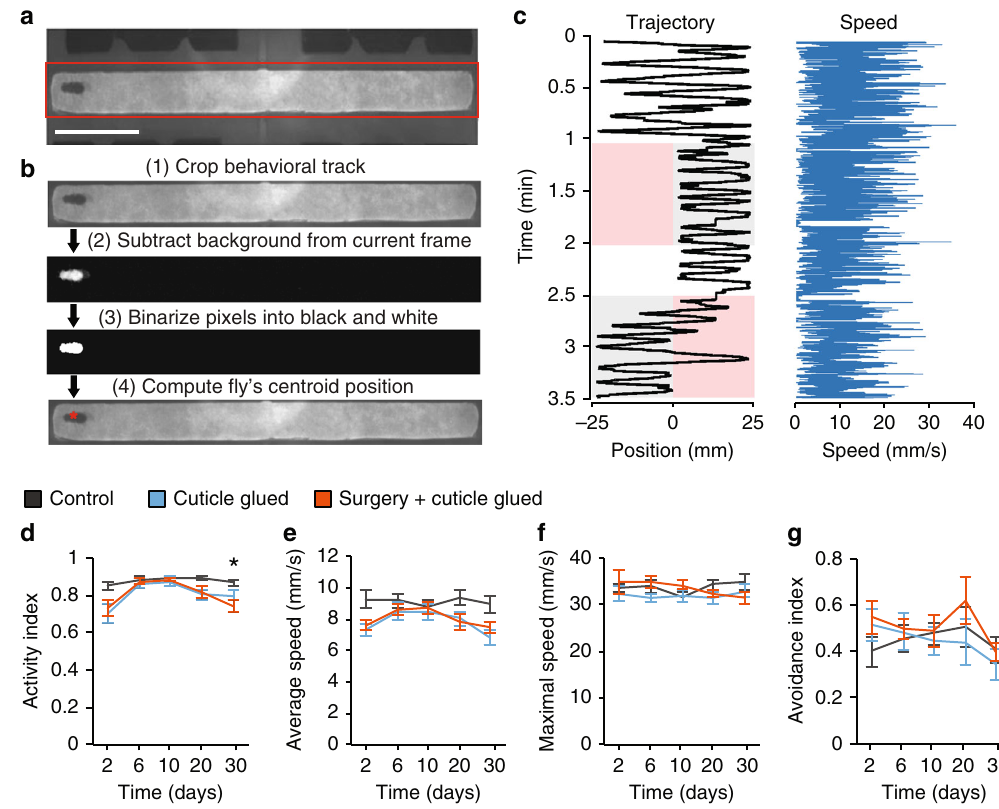
Fig. 3 Virtually normal locomotor and odor avoidance behaviors for 30 days after surgery. a Behavioral chamber for locomotor and odor avoidance assays, with odor delivery inlets at both sides. Red box: image region-of-interest analyzed to track fl y movements. Scale bar: 10 mm. b Fly tracking steps: (1) Isolate the region-of-interest; (2) Subtract the mean background image; (3) Group pixels into background (black) and foreground/object (white) pixels using Otsu ’ s method and fi lter objects by size to isolate the fl y; (4) Compute fl y ’ s current centroid. c An example of walking trajectory (left) and speed trace (right). Repulsive odor, 4-methyl-cyclohexanol (3% in air), entered fi rst from the left and then the right inlet. Pink indicates these intervals and entry routes; the opposite inlet delivered fresh air (gray shading). Otherwise, both inlets delivered air (white). d Flies that had the full surgery or glue on the cuticle had indistinguishable activity indices from control fl ies on Days 6 ( P = 0.9) and 10 ( P = 0.6) (Kruskal – Wallis ANOVA; 10 fl ies per group). On Days 2 ( P = 0.03) and 20 ( P = 0.04), the groups exhibited signi fi cant differences ( n = 8 – 10 fl ies per group; Kruskal – Wallis ANOVA), which were insuf fi cient to yield signi fi cant paired post-hoc tests between groups ( P = 0.06 – 0.9; U -test with Holm – Bonferroni correction). On Day 30, Kruskal – Wallis ANOVA